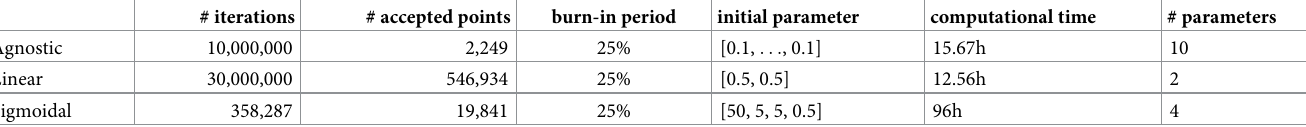
Table 2. Individual settings and corresponding results achieved with the Metropolis-Hastings method for agnostic, linear, and sigmoidal model (shown in particular rows). The columns display the following information respectively: the total number of points explored; the number of accepted points; the proportion of accepted points which were trimmed out from the beginning; the initial parametrisation; the computation time (in hours); and the number of dimensions of the explored parameter space (the number of explored parameters).